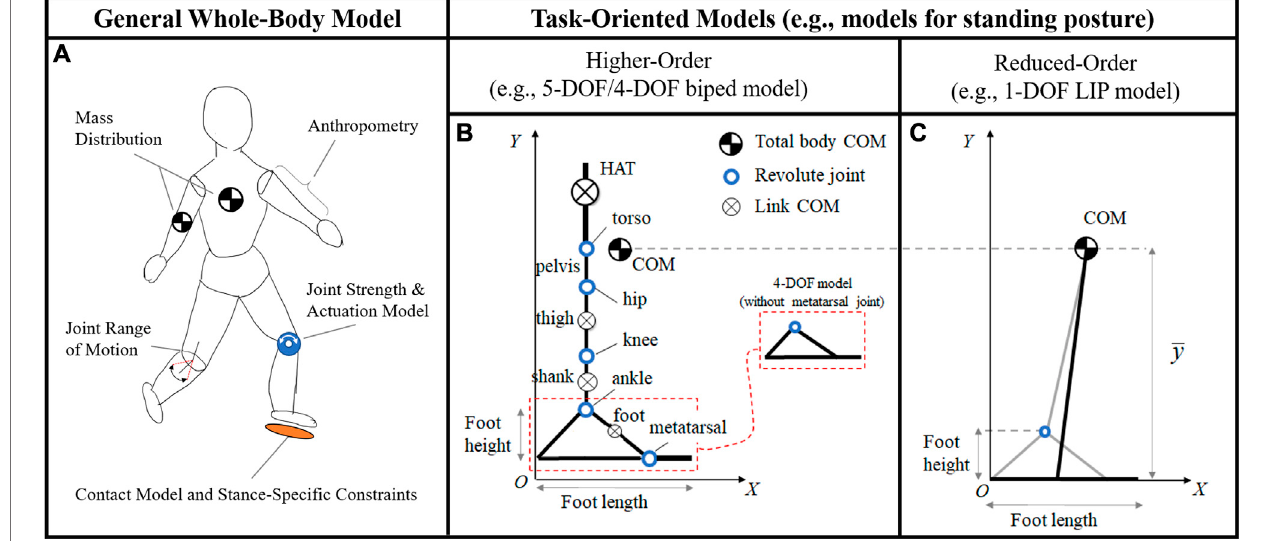
FIGURE 4 | (A) General human body models take into consideration individual anthropomorphic parameters, joint strengths and actuations, mass distributions, range of motions, ground contact modeling, and stance-speci fi c constraints. Whole-body models are valid for the representation of any general motor task, although their simulation can be computationally intractable. In practice, task-oriented models can give a practical computation of the balanced region for the speci fi c task considered.Forbalancestabilityduringstandingposture,bothhigher-andreduced-ordermodelsinthesagittalplanecanbeestablished.Thehigher-ordermodels (B) include more detailed subject-speci fi c parameters at the link and joint level, upper and lower body segments, as well as multi-segment feet (5-DOF model), as described in previous work (Mummolo and Vicentini, 2020). The LIP model (C) constrains the motion of the COM at a fi xed height y , equal to the Y -coordinate of the body ’ s COM while standing and does not include joint-level design